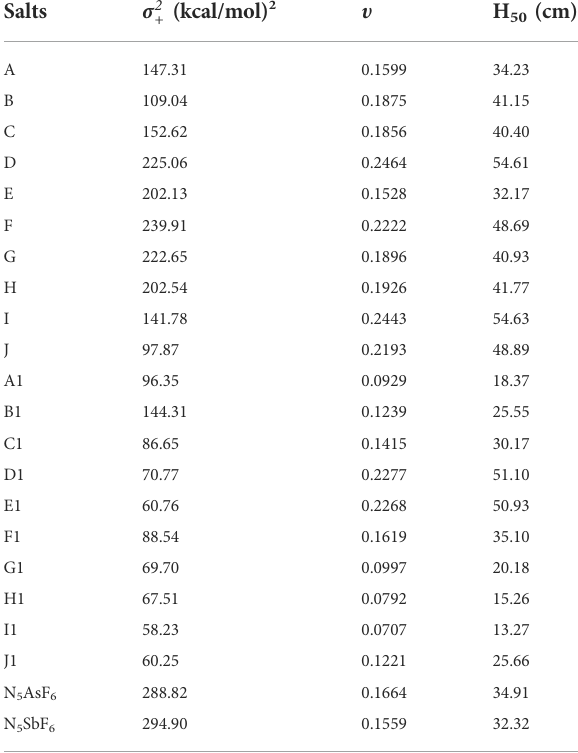
TABLE 4 Values of H 50 for N 5 + and O 2 + salts.